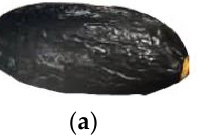
Figure 1. Dabai fruit ( a ) before ( b ) after blanching.